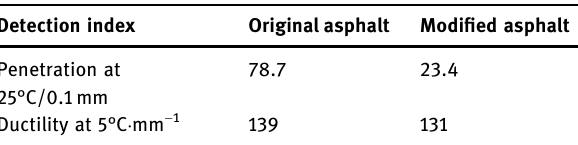
Table 3: Comparison of indexes before and after asphalt modi fi cation Detection index